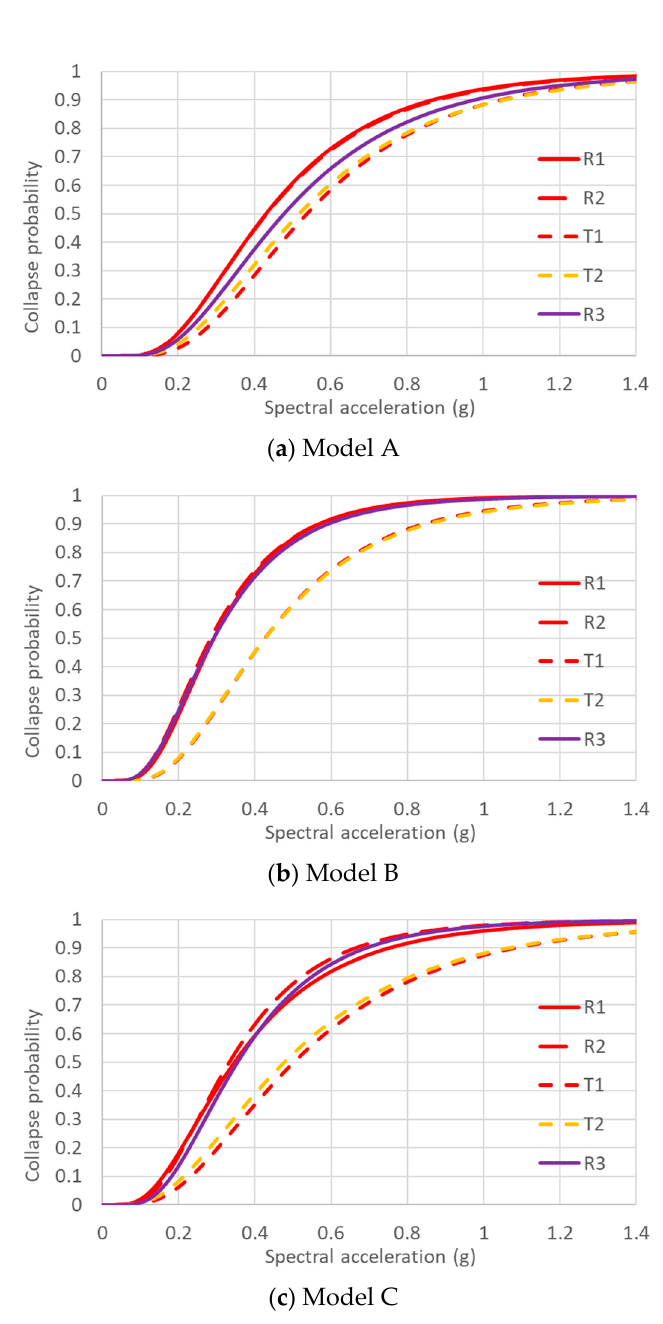
Figure 15. Seismic fragility curves for individual component wall based on governing failure modes. Table 10. Summary of collapse probability for analytical models designed for the shear force amplification factor = 1.2.